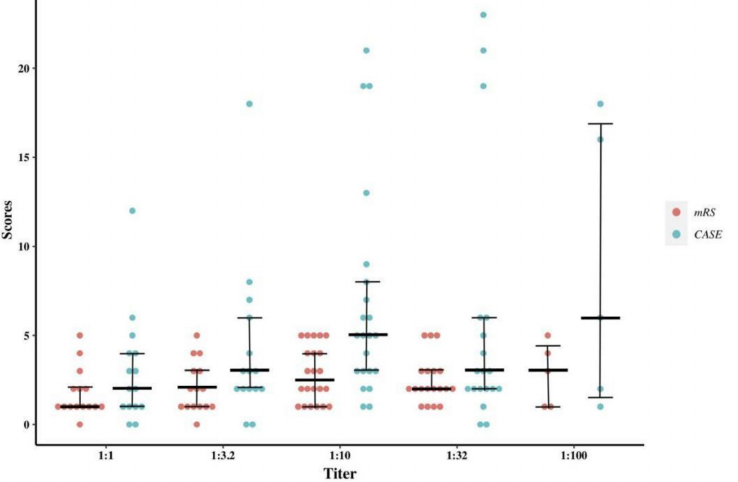
Figure 4. Relationship between mRS and CASE scores and antibody titers. The horizontal thick black lines indicate the median scores of each group, and the upper and lower lines represent the first and third quartiles. Abbreviations: CASE, clinical assessment scale for autoimmune encephalitis; mRS, modified Rankin scale. Table 3. Correlation between cerebrospinal fluid antibody titers and severity according to mRS or CASE